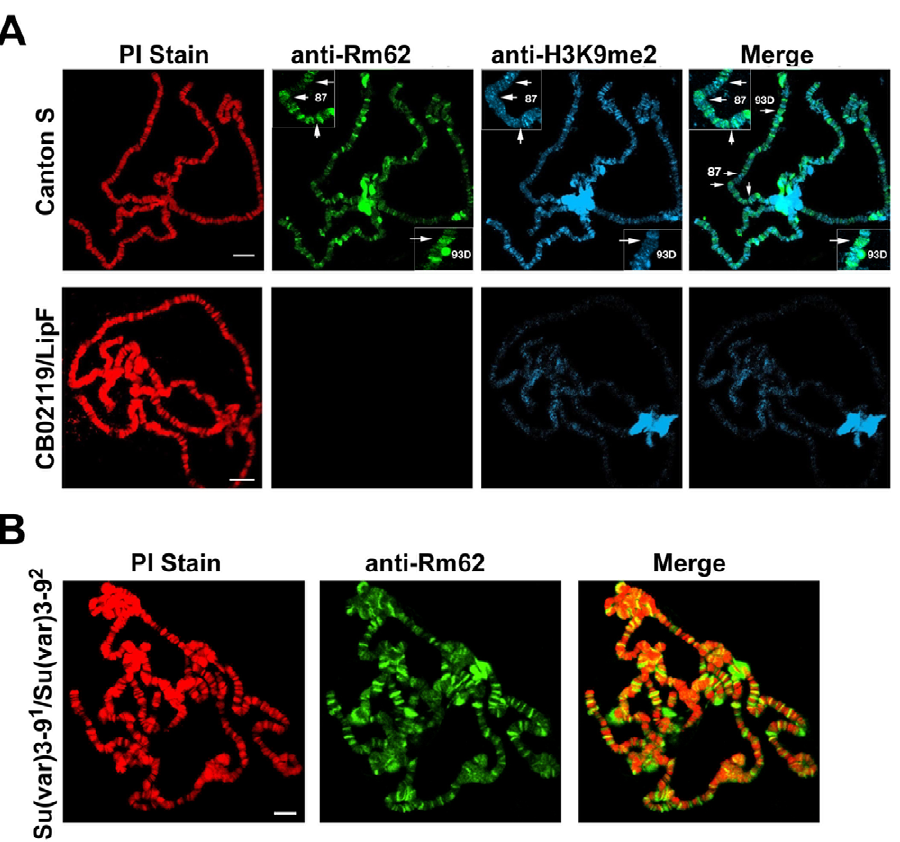
Figure 6. Global effect of Rm62 on H3K9me2. ( A ) Immunostaining of polytene chromosomes of third instar wildtype and heteroalleleic Rm62 ( CBO2119/LipF ) mutant larvae with Rm62 (green) and H3K9me2 antibodies (blue). The left panel shows a merge of the signals of an anti Rm62 and an anti H3K9me2 staining showing a large portion of costaining. Inserts show an enlargement of the heat shock loci on chromosome 3. The chromosomes were counterstained with PI (red) Scale 2 10 m m. ( B ) Immunostaining of polytene chromosomes of third instar Su(var)3-9 mutant larvae ( Su(var)3-9 1 /Su(var)3-9 2 ) with Rm62 antibodies (green) show no disturbance of Rm62 binding. The chromosomes were counterstained with PI (red) Scale 2 10 m m.